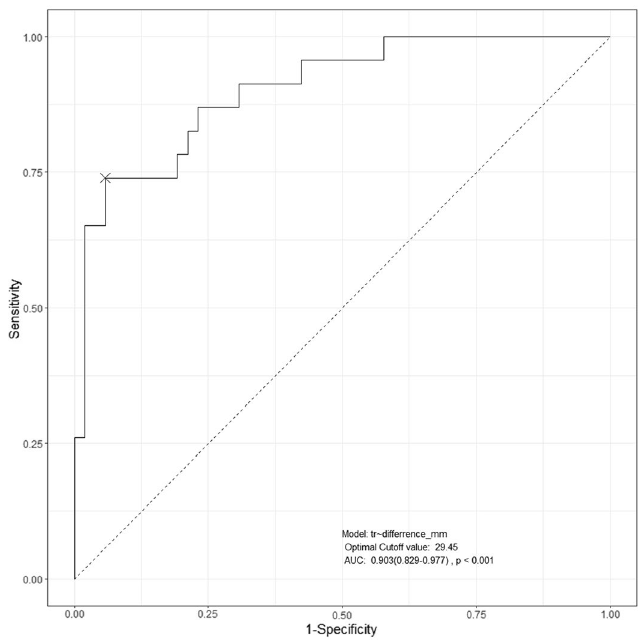
Figure 4. Receiver operating characteristic curves for elevation of the hemidiaphragm on chest radiographs. Optimal cut-off value: 29 mm (sensitivity 73.9%, specificity 94.2%) with an area under curve of 0.903 (95% CI 0.829 to 0.977; P <